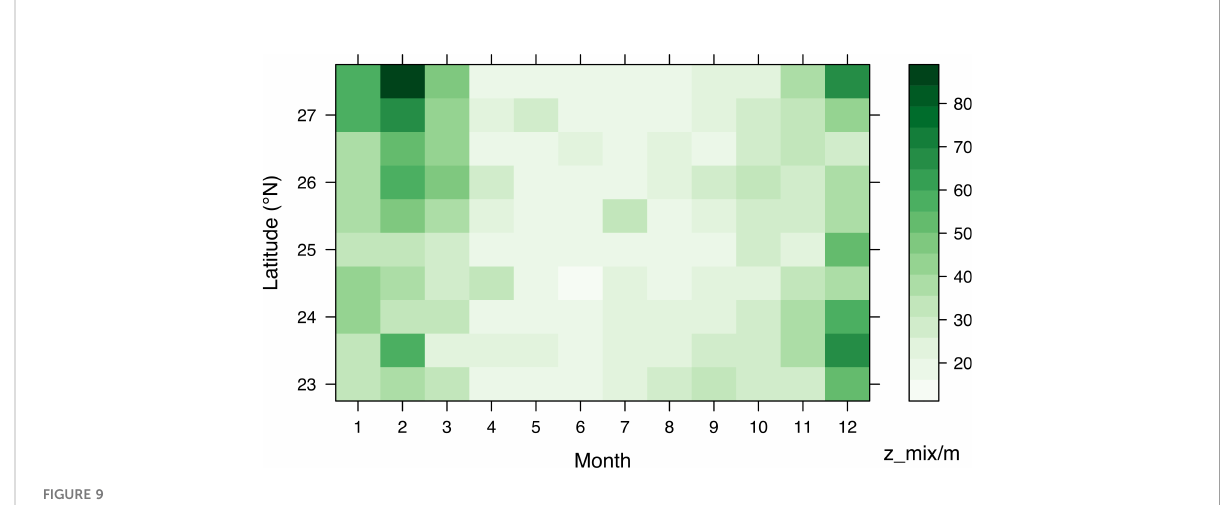
FIGURE 9 Mixed layer depth by month and latitude (Abdulla et al.,